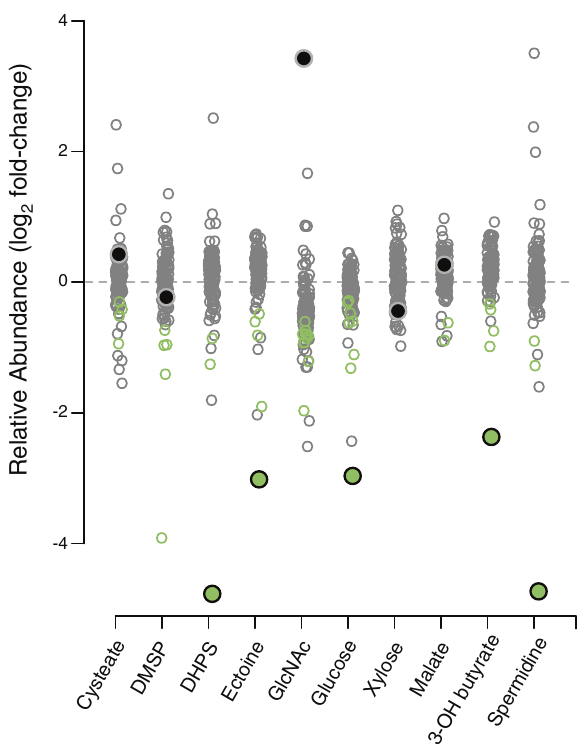
Fig. 3 Relative abundance of Ruegeria pomeroyi DSS-3 transpor- ter mutants following selection of the pooled-RB-TnSeq library for growth on 10 metabolites. Green symbols indicate signi fi cant mutant depletion ( t test, n = 4, Benjamini-Hochberg adjusted p ≤ 0.05) and gray symbols indicate non-signi fi cant changes. The larger fi lled symbols indicate the identi fi ed transporter for that metabolite as determined from growth and drawdown assays of individual mutants, and is colored green if it was correctly identi fi ed, and colored gray if not. Mutant enrichment/depletion for multi-gene transporter systems is plotted as the average of all